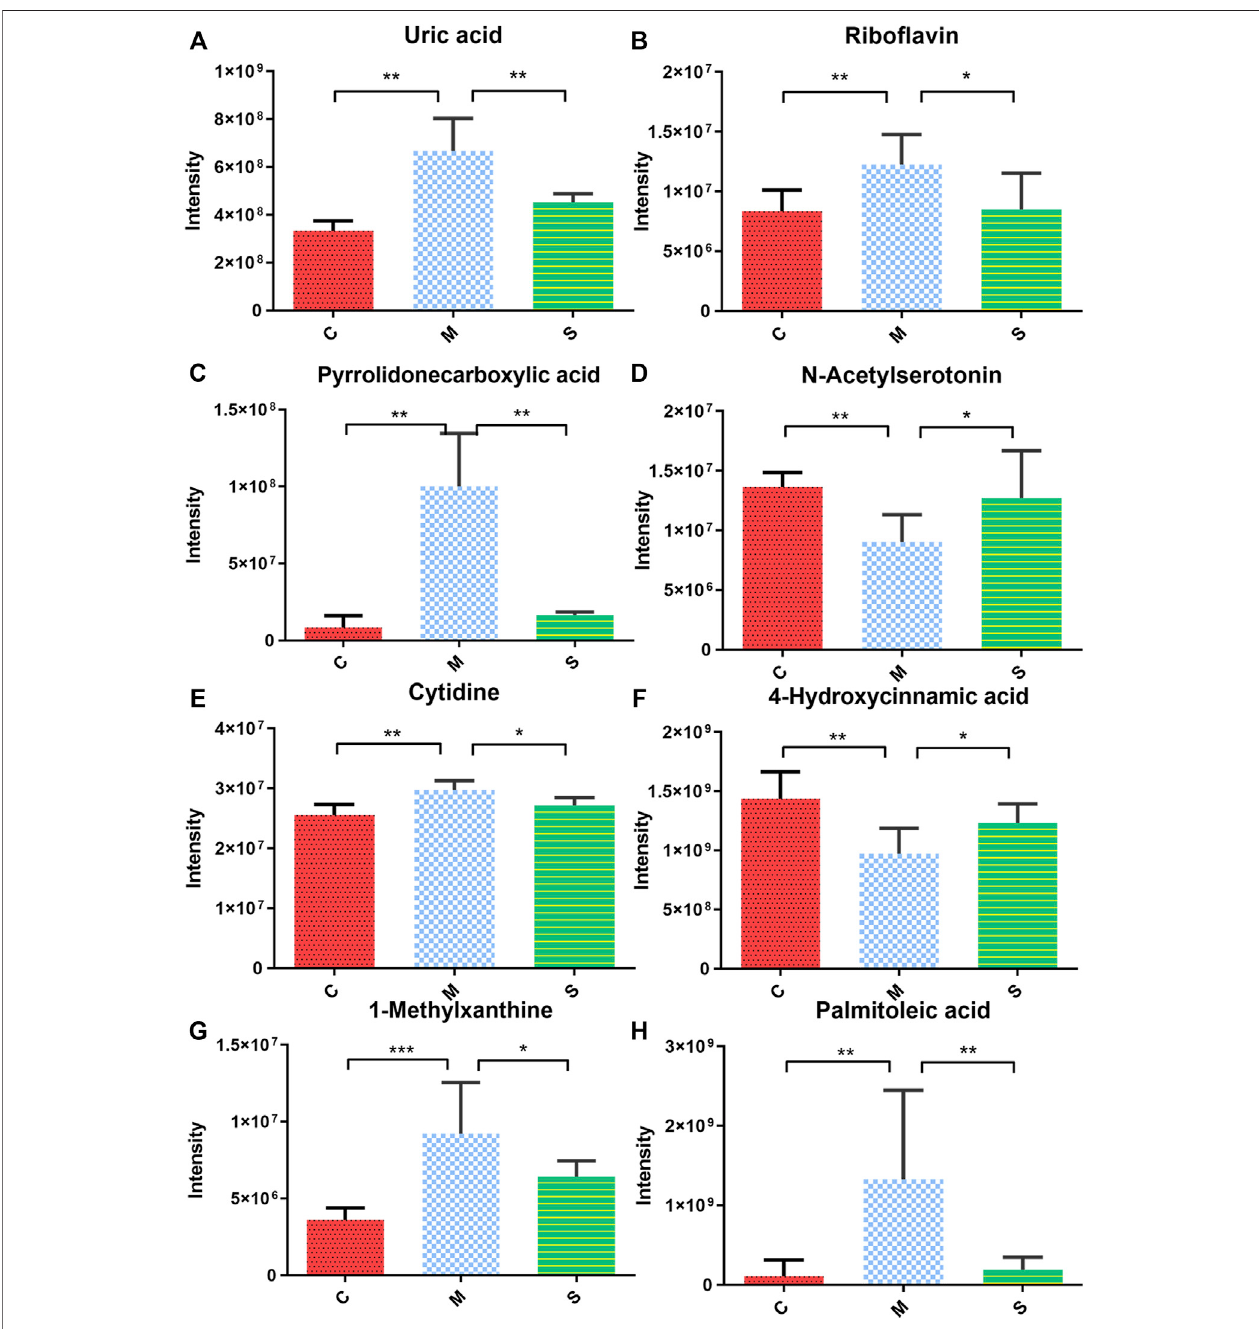
FIGURE4| Expressionofserumbiomarkersinallgroups,* p < 0.05,** p < 0.01themodelgroupscomparedwiththeothergroups; (A) Uricacid; (B) Ribo fl avin; (C) Pyrrolidonecarboxylic acid; (D) N-Acetylserotonin; (E) Cytidine; (F) 4-Hydroxycinnamic acid; (G) 1-Methylxanthine; and (H) Palmitoleic acid.